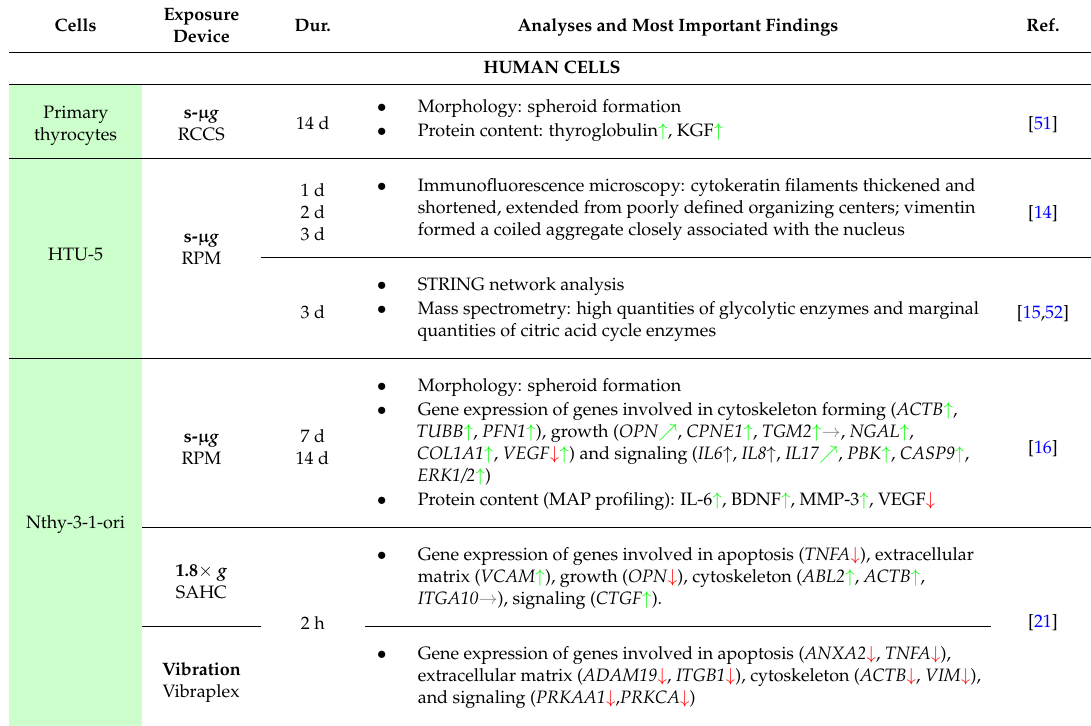
Table 1. Research on thyroid cells under the effects of altered gravity (green: normal cells, yellow: cancer